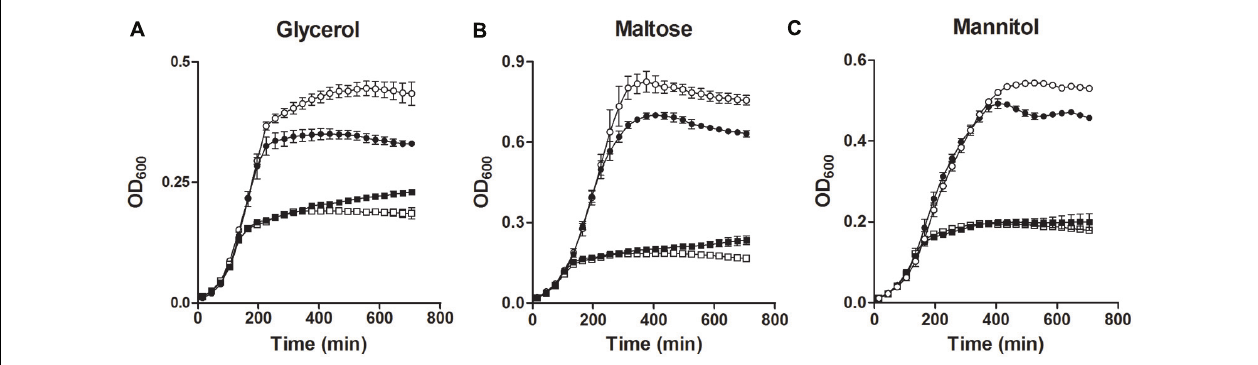
FIGURE 6 | Effect of MafR on the utilization of different carbon sources. Bacteria were grown in M9YE medium supplemented (circles) or not (squares) with glycerol (A) , maltose (B) , or mannitol (C) . White symbols correspond to strain OG1RF. Black symbols correspond to strain OG1RF (cid:2) mafR . Data correspond to the mean values of three independent experiments. Error bars indicate standard error of mean.